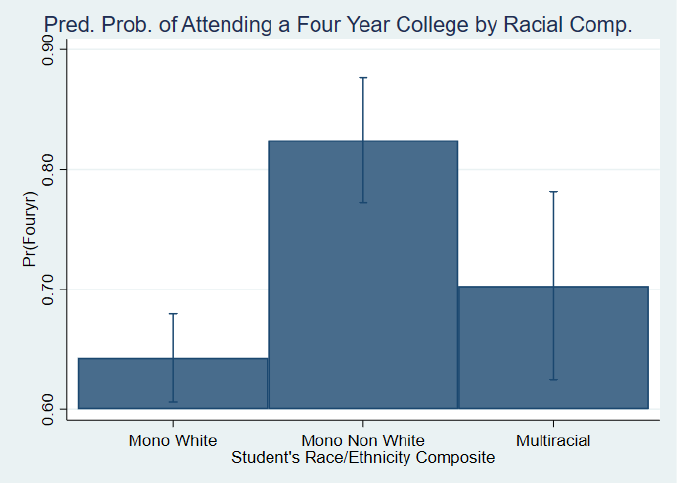
Figure 7. Pred. Prob. of Attending a Four Year Institution by Racial Comp. using Add Health Data.